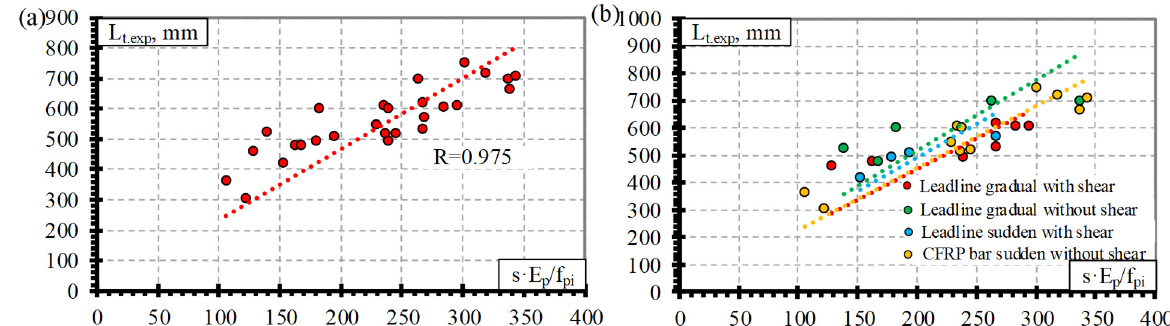
Figure 5. Comparison between the transfer length of CFRP bars and s·E p /f pi : ( a ) all results, ( b ) effect of reinforcement type, reinforcement release type and shear reinforcement.